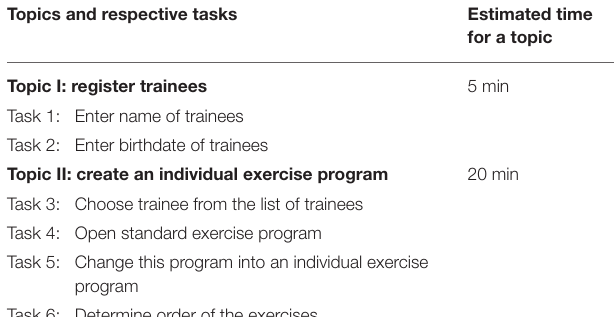
TABLE 1 | Tasks designed for the Therapists. Topics and respective tasks Estimated time